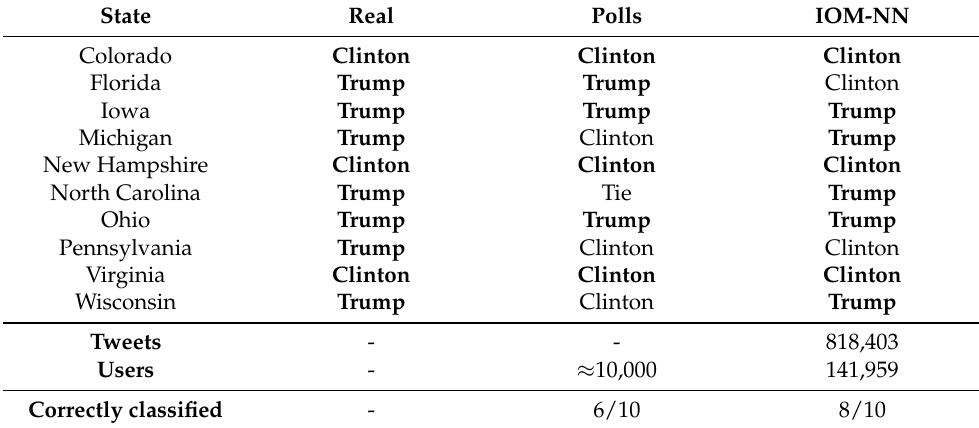
Table 2. Results comparison in terms of winning candidate. Candidate is written in bold when correctly identified.